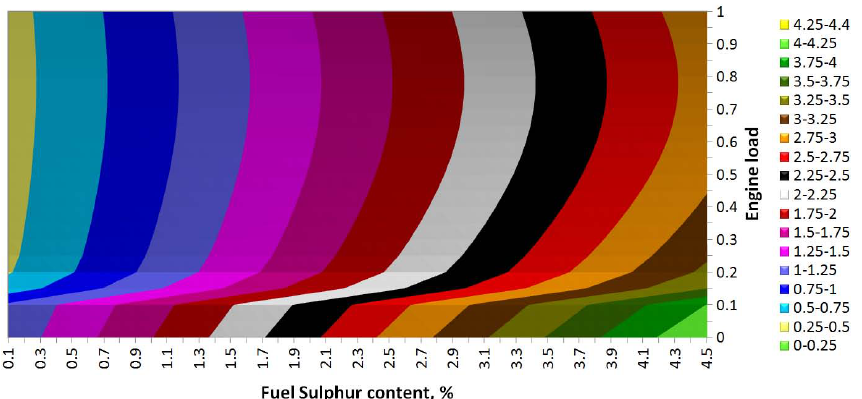
Fig. 4. The predictions of the STEAM2 model for total PM emission factor (legend, in units of gkWh − 1 ) as a function of engine load and fuel sulphur